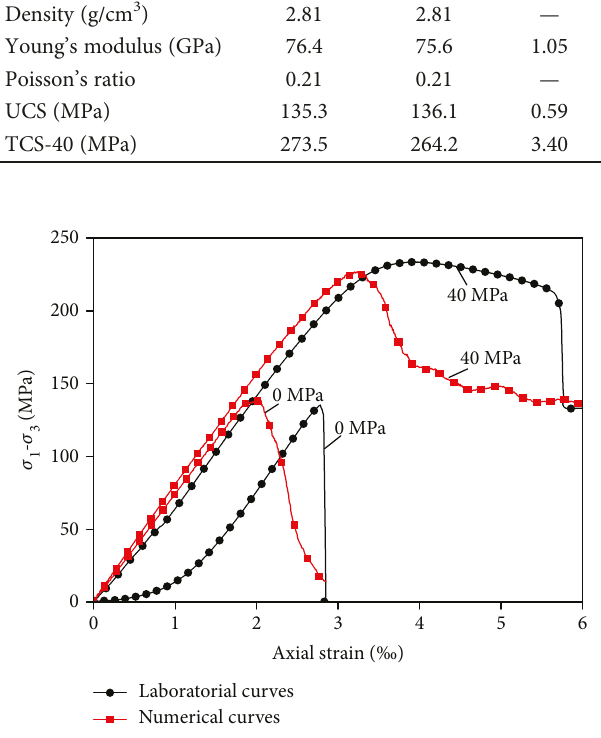
Figure 5: Laboratorial and numerical stress-strain curves of the marble specimen under